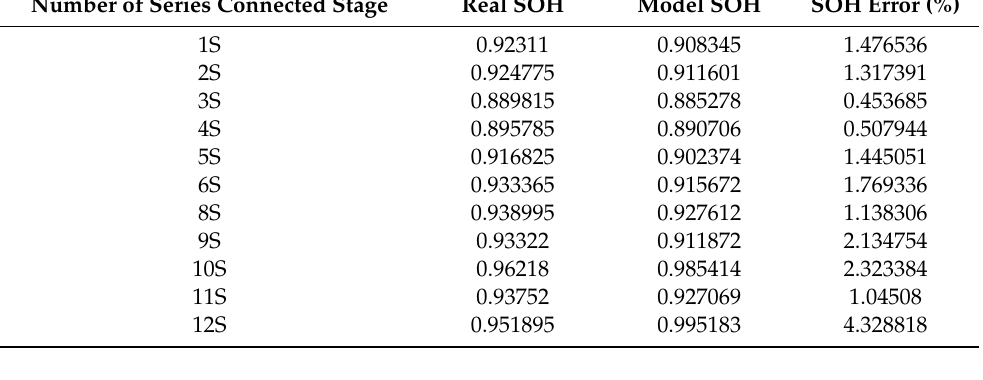
Figure 23. Comparison between the linear regression model based on the partial capacity of cell no.1 and a real SOH based on the partial capacity of the 12 series ‐ connected stages of the retired series/parallel battery pack.